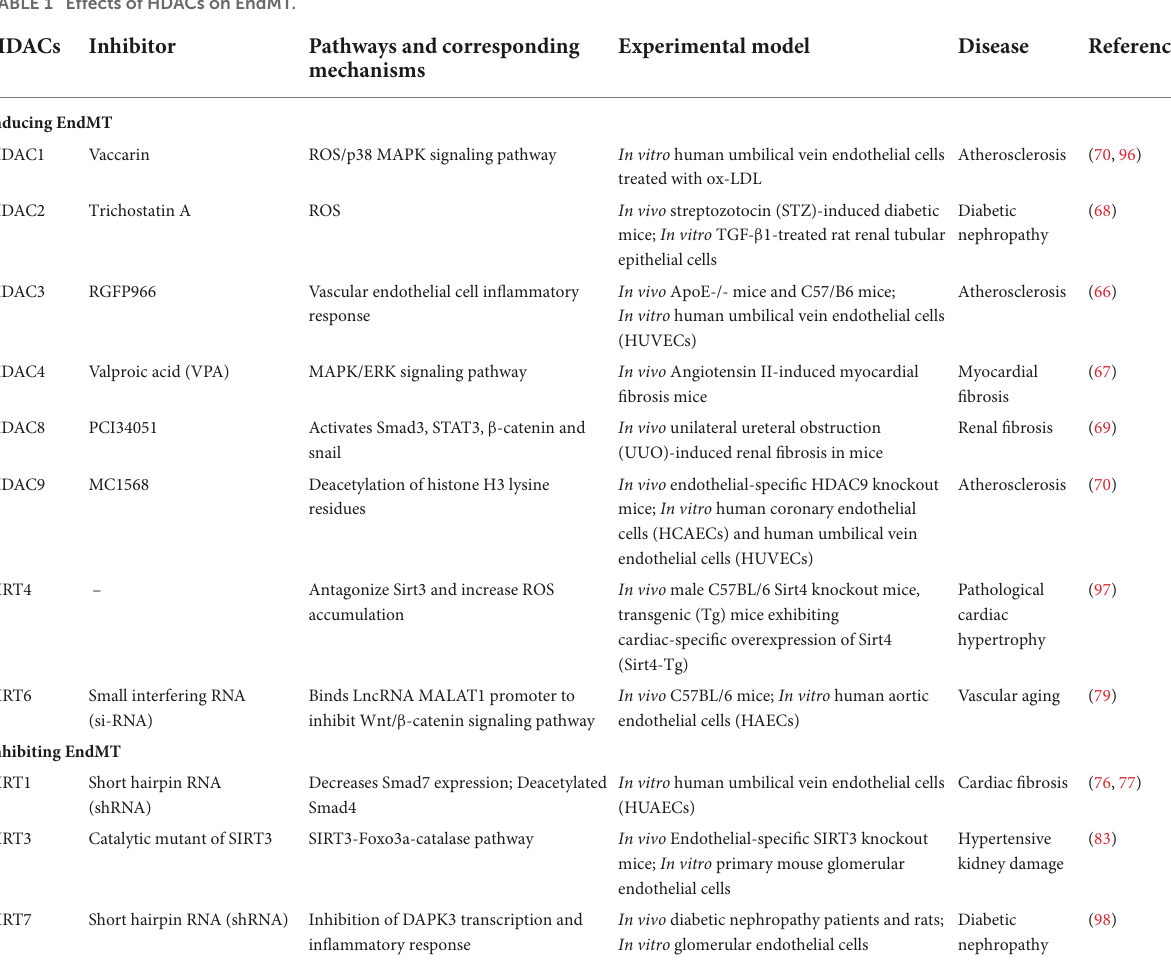
TABLE 1 Effects of HDACs on